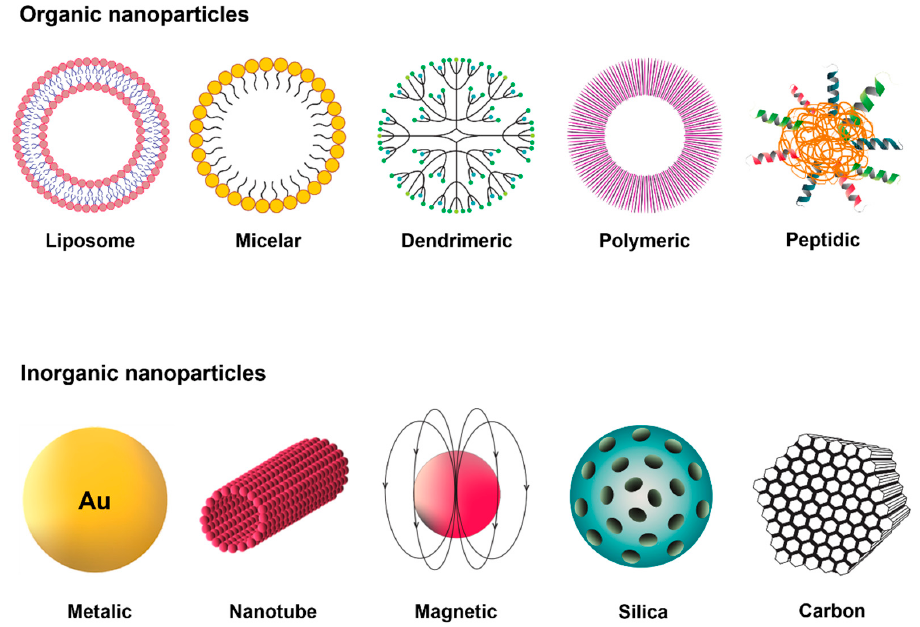
Figure 4. Different representations of the two large groups of NPs. These NPs are commonly used for biomedical applications and offer a significant potential as DDSs for cancer. They are divided into organic or inorganic, depending on the kind of material used for their composition.